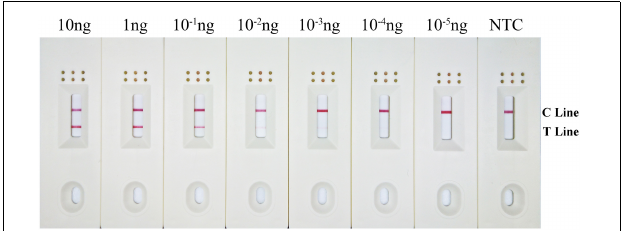
FIGURE 6 | Detection limit of the RPA–LFD assay. The image shows the LFD results of RPA amplification with different concentrations of B. xylophilus gDNA. The DNA concentration used as template is shown above each dipstick. NTC is the no template control. The reactions are carried out at 38 ◦ C for 10 min. Test line and control lines are shown on the right side of